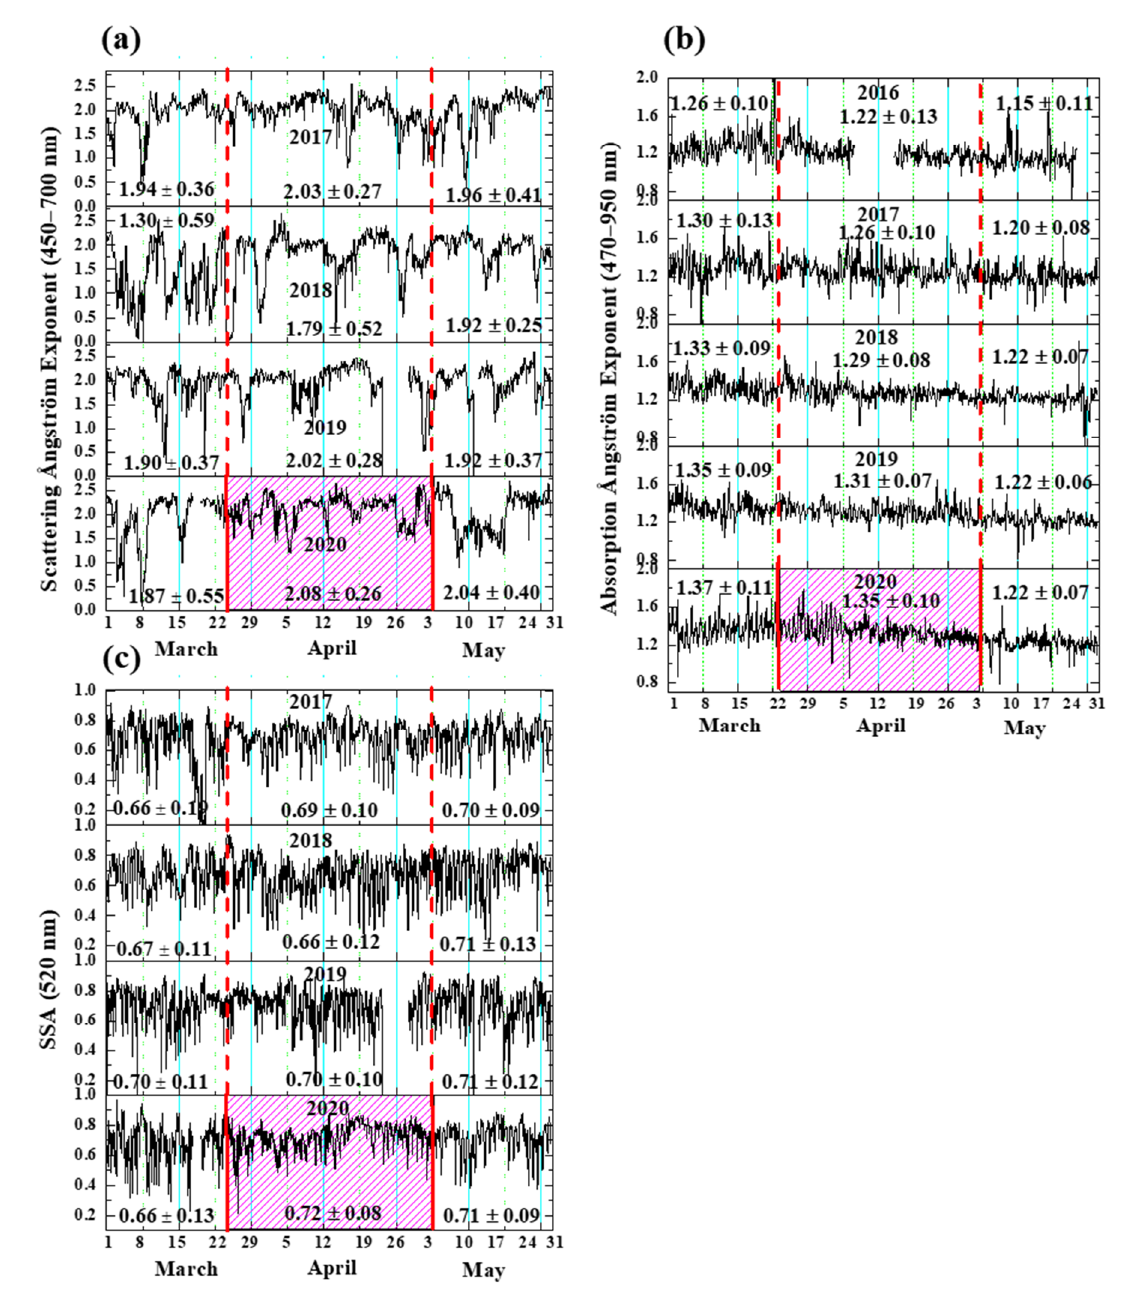
Figure 5. Time-series of hourly scattering absorption exponents (SAE) ( a ), Ångström absorption exponents (AAE) ( b ) and single-scattering albedo (SSA) ( c ) values during March–May for the years 2017–2020 (2016–2020 for AAE). The shaded area in 2020 corresponds to the lockdown period, and the red lines indicate periods before and after the lockdown. Mean values and standard deviations for each sub-period are mentioned in each panel.